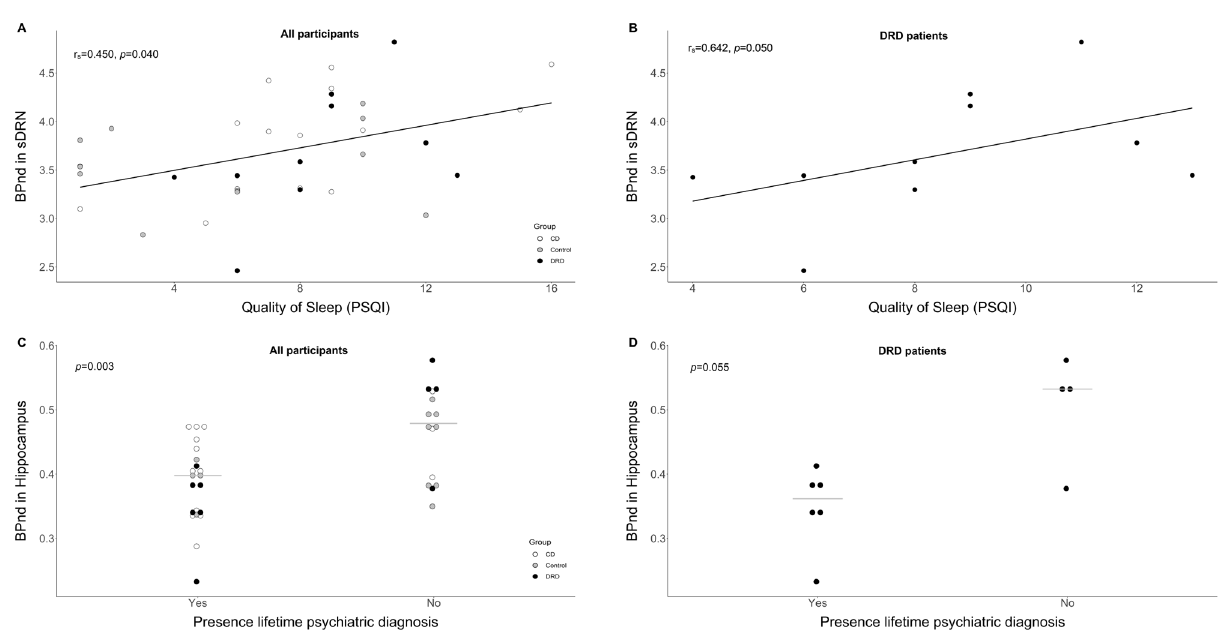
Figure 4. Associations between non-motor symptoms and non-displaceable binding potential ( BP ND ). ( A ) Correlation, calculated with Spearman’s rho test, between quality of sleep and BP ND in dorsal raphe nucleus (sDRN) in all participants, p-value is corrected for multiple comparisons. ( B ) Correlation, calculated with Spearman’s rho test, between quality of sleep and BP ND in sDRN in DRD patients, p-value is corrected for multiple comparisons. ( C ) Dotplot with median (line) of BP ND in hippocampus and presence of a life time psychiatric diagnosis in all participants. ( D ) Dotplot with median (line) of BP ND in hippocampus and presence of a life time psychiatric diagnosis in DRD patients. All results of the correlation analysis can be found in Supplementary Fig.